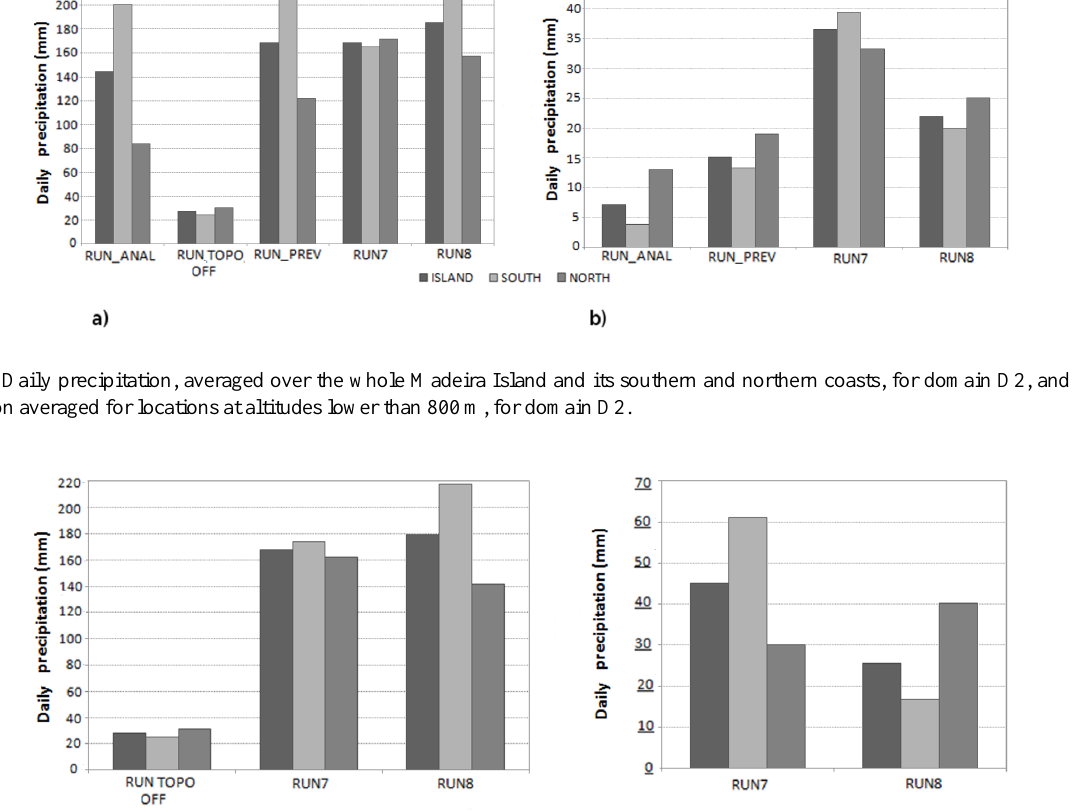
Fig. 7. Percentage of total daily precipitation explained by convective precipitation for locations below 800m.